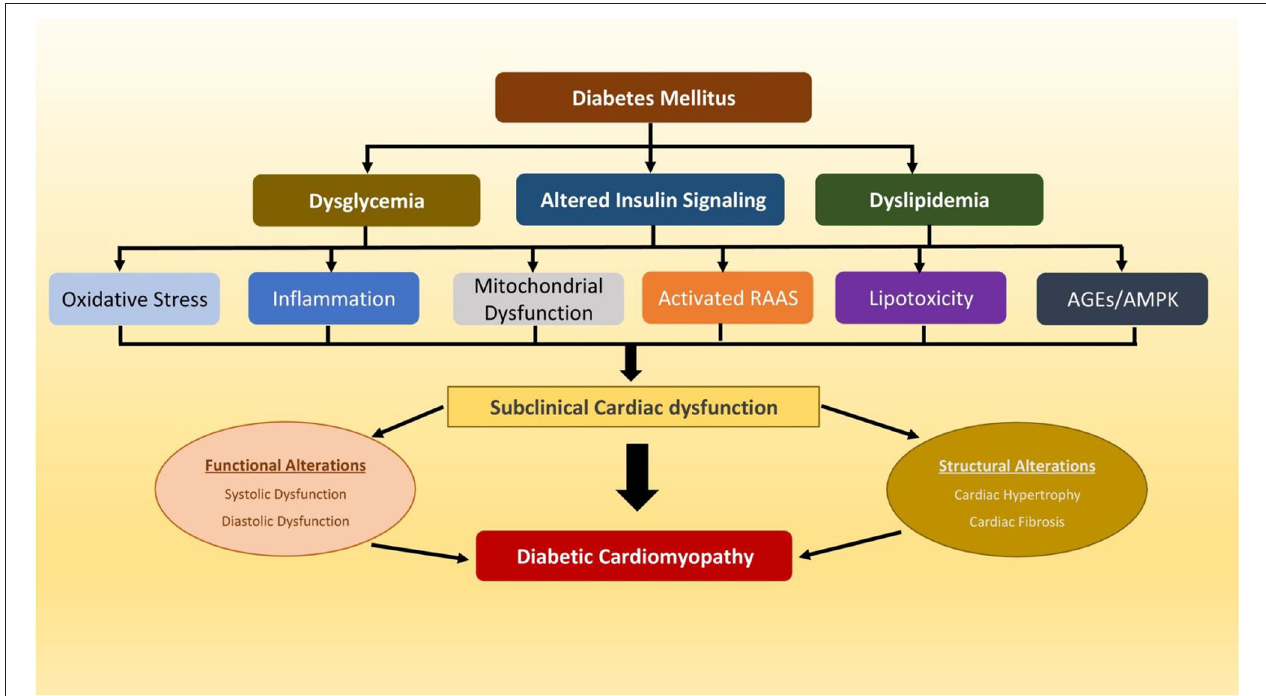
FIGURE 1 | A schematic diagram depicting multiple potential mechanisms that have been implicated in pathophysiology of diabetic cardiomyopathy. AGEs, advanced glycation end products; AMPK, AMP-activated protein kinase; RAAS, renin-angiotensin-aldosterone system.